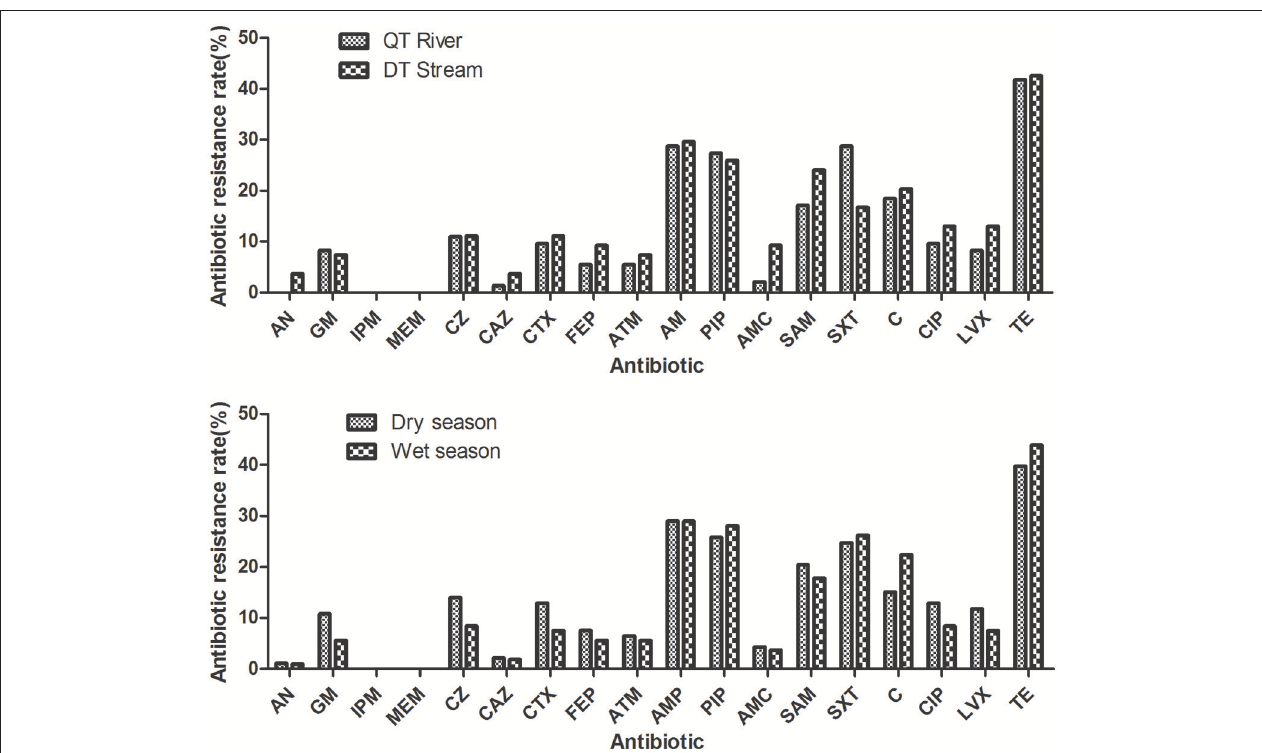
FIGURE 3 | Antibiotic resistance rates of the E. coli isolated from the Qiantang River and the Dongtiao Stream over two seasons. AN, amikacin; GM, gentamicin; IPM, imipenem; MEM, meropenem; CZ, cefazolin; CAZ, ceftazidime; CTX, cefotaxime; FEP, cefepime; ATM, aztreonam; AMP, ampicillin; PIP, piperacillin; AMC, amoxicillin/clavulanate; SAM, ampicillin/sulbactam; C, chloramphenicol; CIP, ciprofloxacin; LVX, levofloxacin; TE, tetracycline.